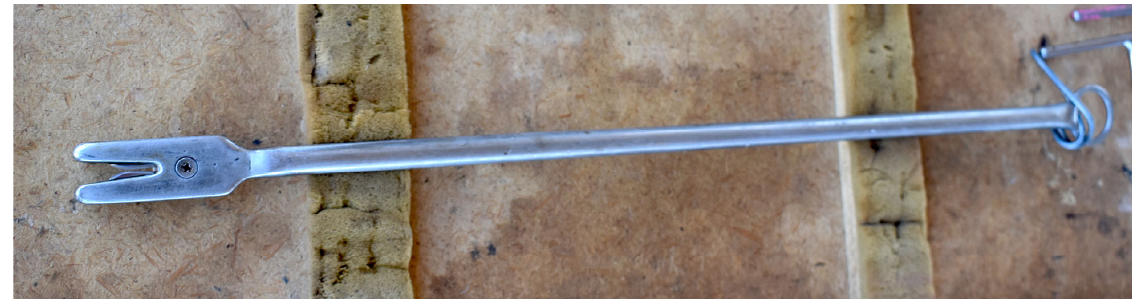
Figure 3. The custom ‐ made uterine tube cutting tool.